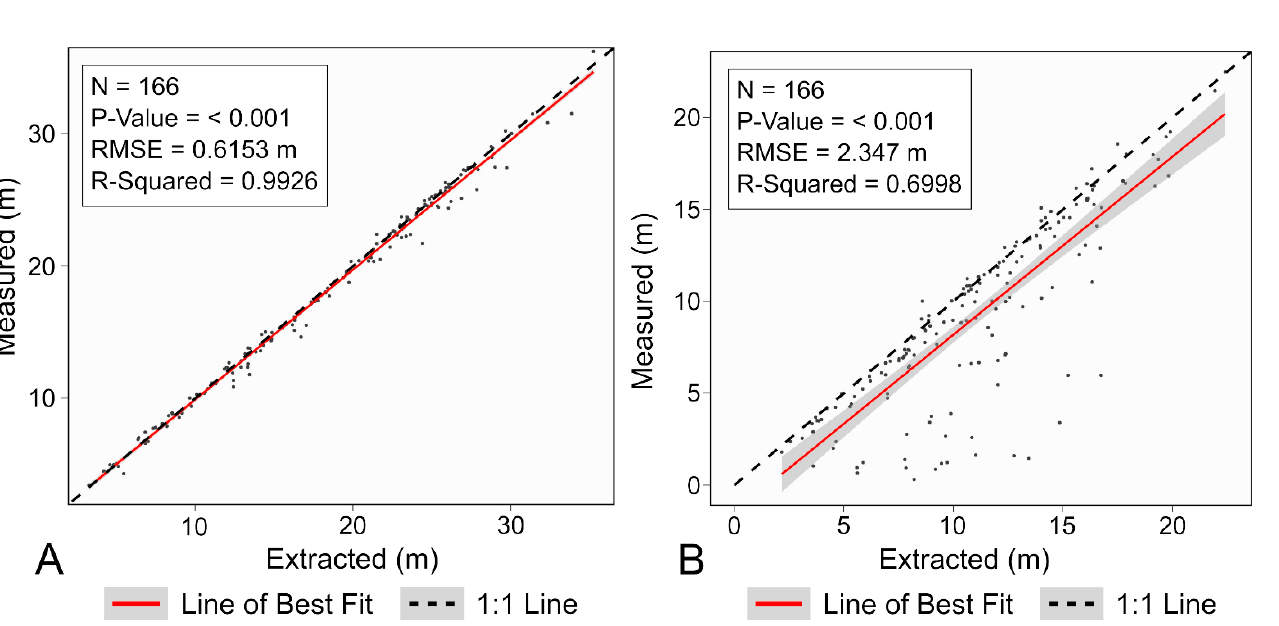
Figure 6. Agreement between measured and extracted ( A ) upper and ( B ) lower boundaries of live branch clusters. In each panel, the line of best fit is displayed in red and the 1:1 line is shown as the dashed black line.